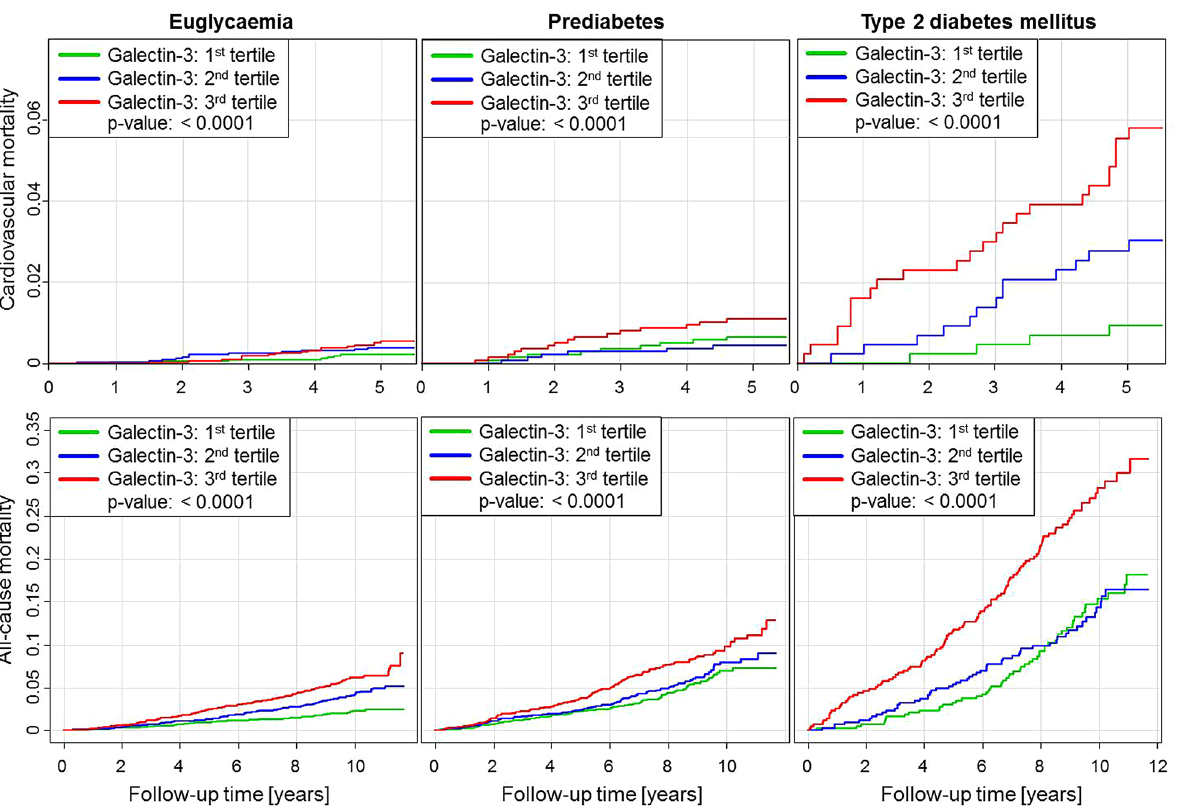
Figure 2. Galectin-3 and mortality in euglycaemia, prediabetes and type 2 diabetes mellitus. Cumulative incidence plots showing the association between Galectin-3 tertiles and cardiovascular as well as all-cause mortality in euglycaemia, prediabetes and type 2 diabetes mellitus. Galectin-3 tertiles are coloured as following: first tertile green, second tertile blue, third tertile red. P for trend is provided in all panels. The figure was created using the software package R (R Core Team, R version 4.0.5 (2021–03-31). R: a language and environment for statistical computing. R Foundation for Statistical Computing, Vienna, Austria, 2021, URL https:// www.R- proje ct.